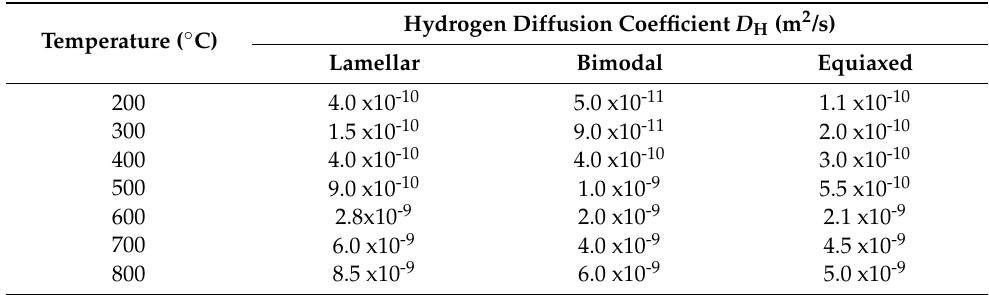
Table 2. Hydrogen diffusion coefficient for different solution treatment conditions, data from